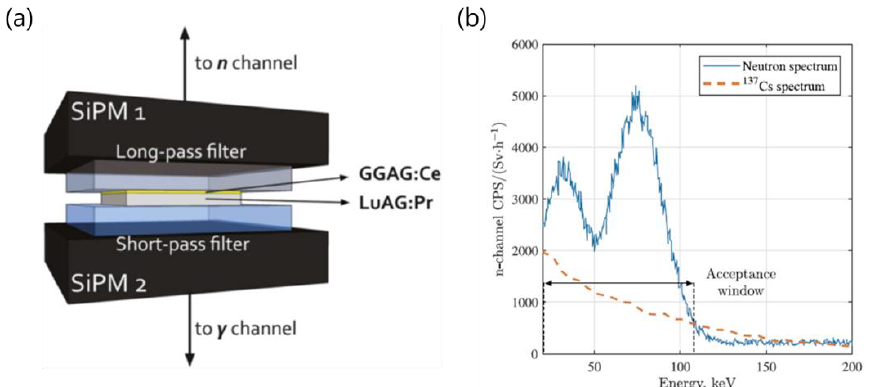
Figure 28. Schematic of the Phoswich arrangement ( a ) and comparison between the n-channel multichannel spectra obtained by irradiating with neutrons (solid blue line) and 137Cs (dashed red line) without implementing the anti-coincidence logic ( b ) [61].